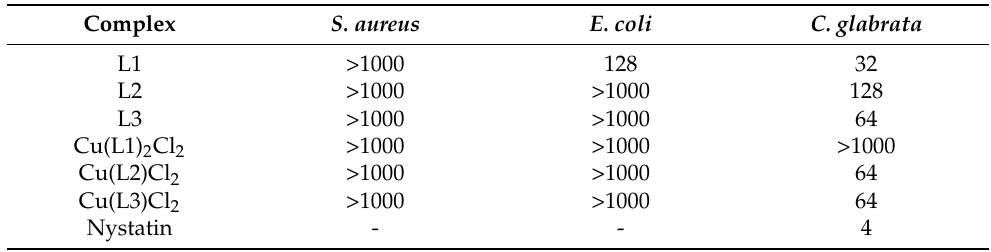
Results of the minimal inhibitory concentration assays established for microbial strains ( µ g/mL). Complex S. aureus E. coli C.